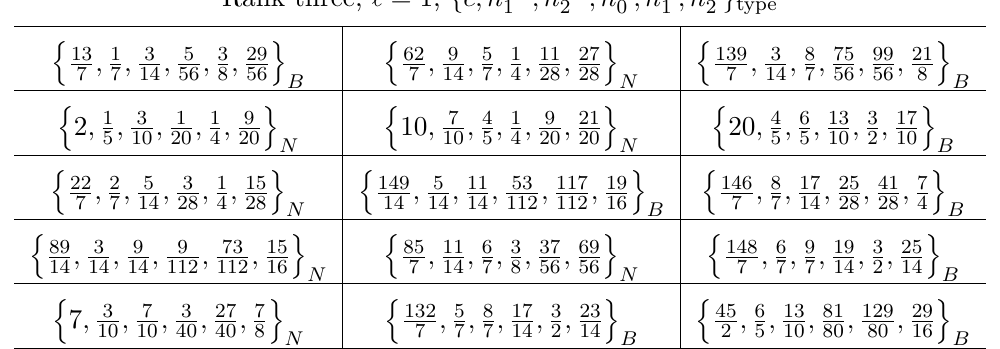
Table 6 . Rank 3 non-degenerate unitary theories with ‘ = 1 . Type: S=SUSY, B=SUSY Broken, N=non-SUSY.